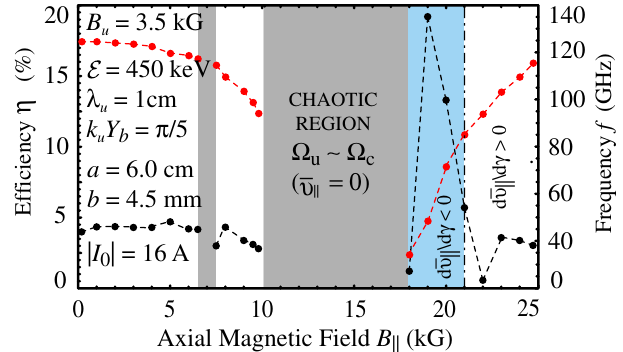
FIG. 8. The FEL efficiency and the resonant frequency vs the axial magnetic field. The results of the simulation are based on the nonsimplified model.